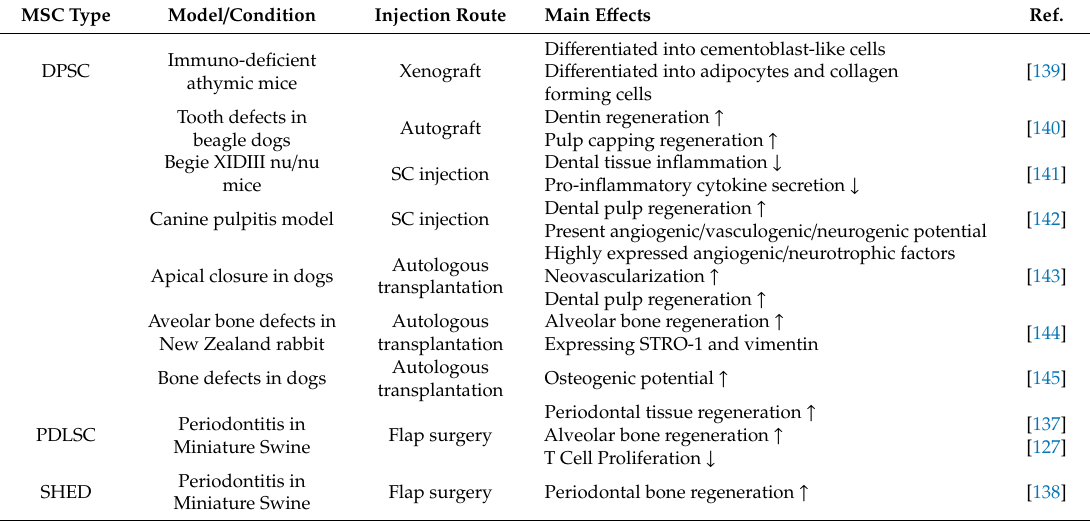
Table 2. Therapeutic application of dental MSCs to induce dental